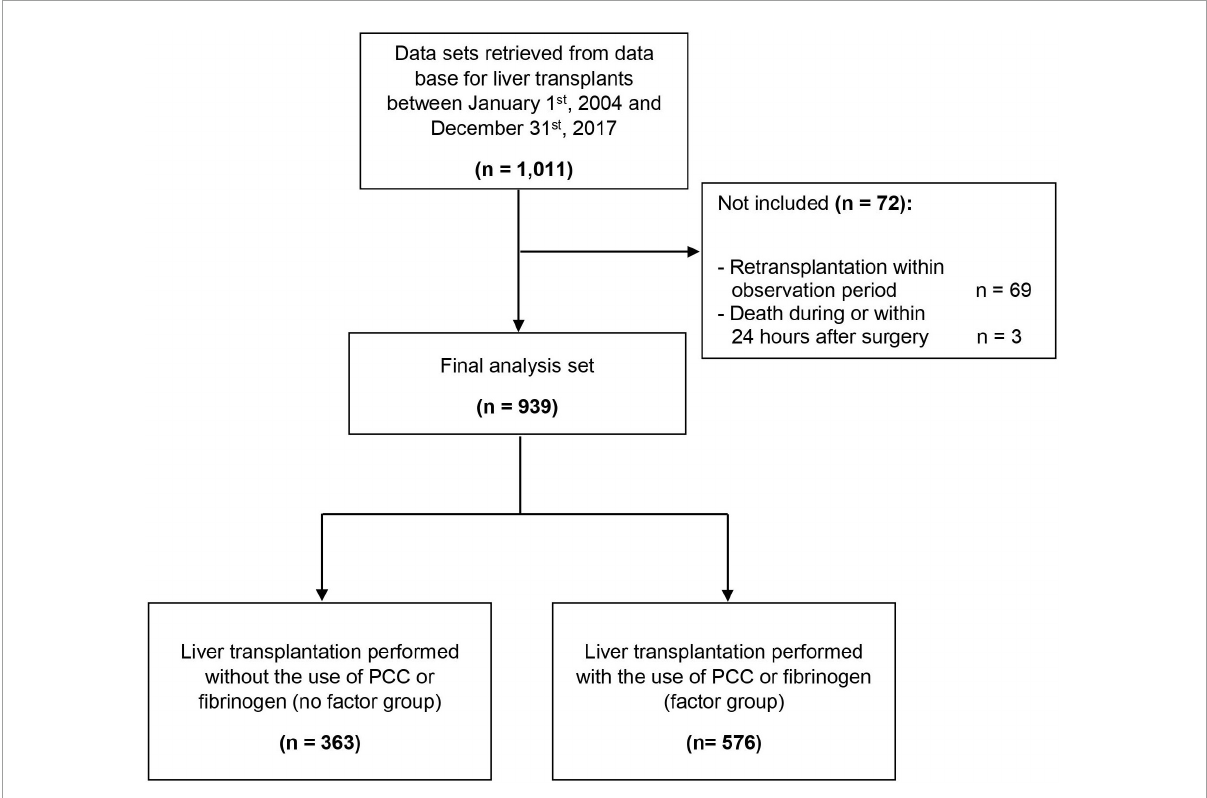
FIGURE1 Participant flow chart. PCC, prothrombin complex concentrate.